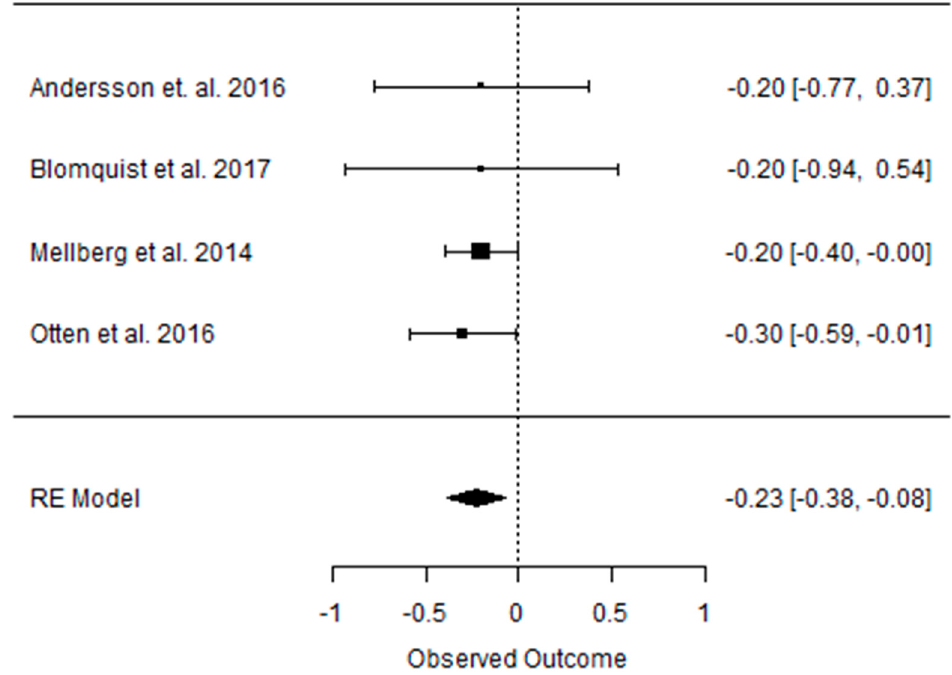
Figure A26. Forest plot of the effect of a PD on TC in the long term (weighted mean difference).